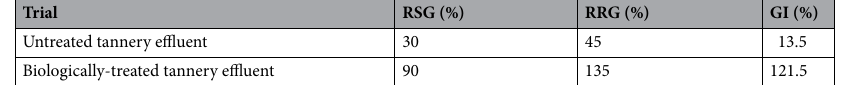
Table 4. The influence of the tannery effluent on the germination of Lepidium sativum seeds.